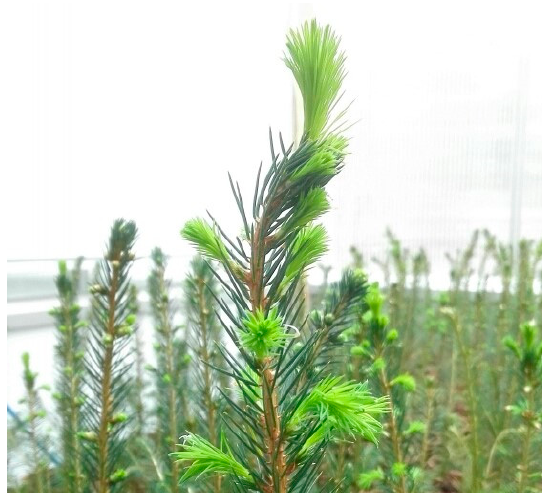
Figure 3. Young spruce sprouts used as a starting material for 1,6-dehydropinidine extraction. (Photograph Virpi Virjamo).